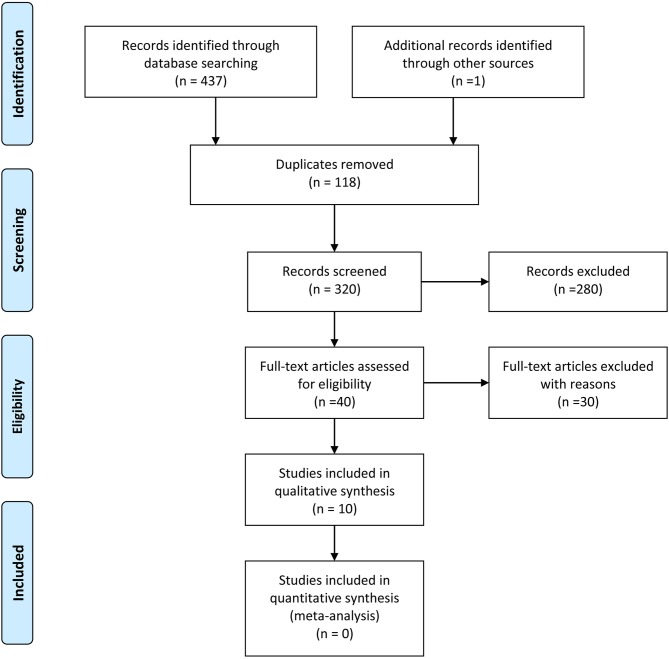
PRISMA flow chart.